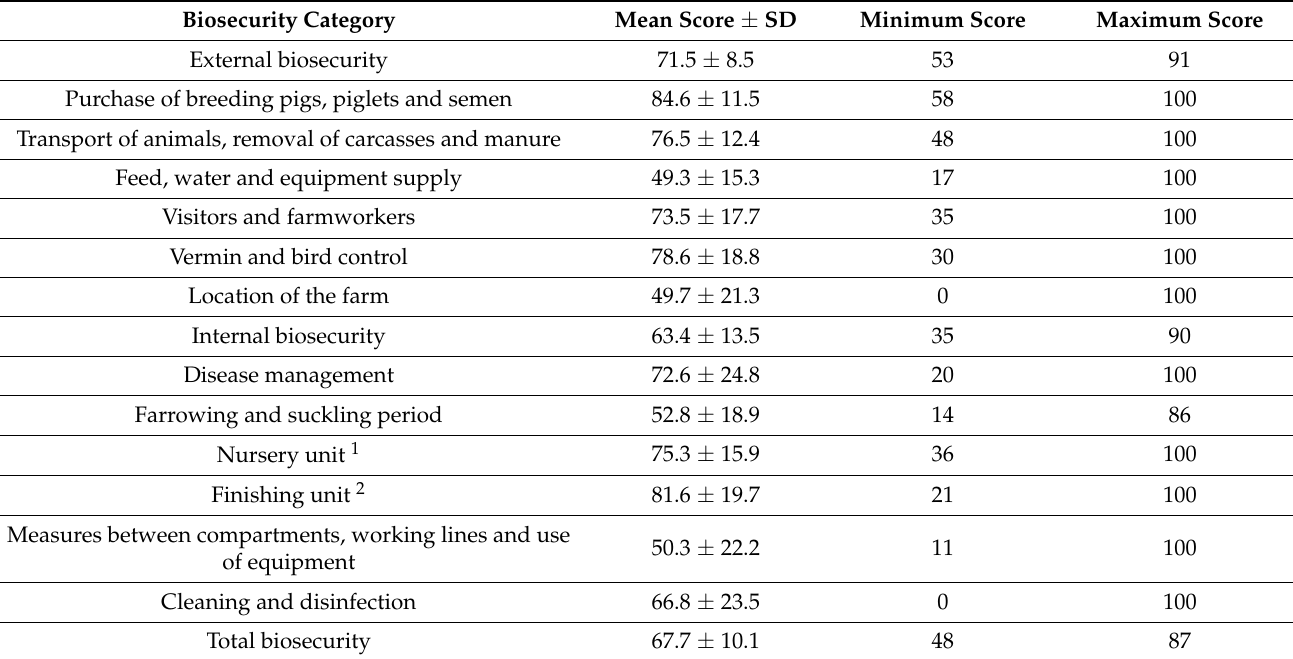
Table 1. Biosecurity data of 70 selected Belgian sow herds that practice routine vaccination against Porcine Reproductive and Respiratory Syndrome virus (PRRSv). Biosecurity scores are determined by the BioCheck questionnaire. Scores are shown as the mean ± standard deviation (SD) and minimum and maximum score for each biosecurity category. Scores can range from a minimum of 0 to a maximum of